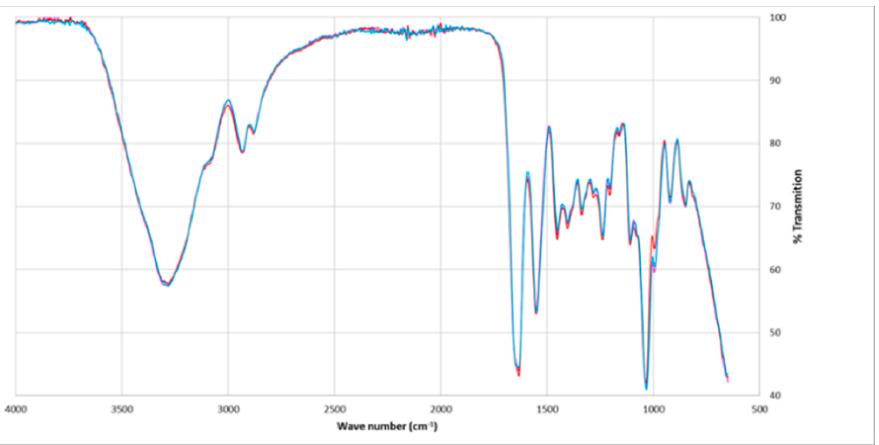
Figure 7. Fourier transform infrared (FTIR) spectra of the bioplastics generated with piscine, porcine, and bovine gelatine and potato starch.